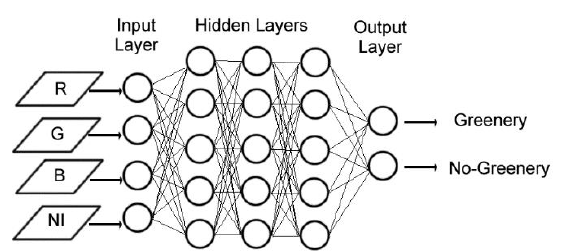
Figure 3. The structure of the proposed neural network model